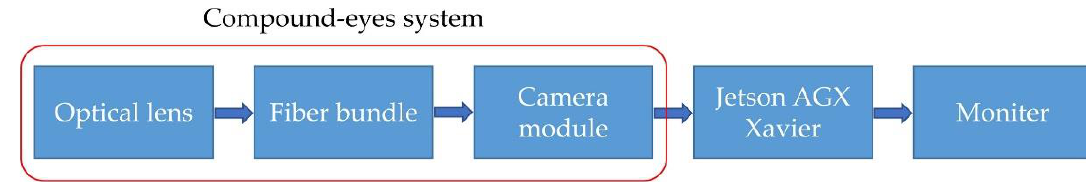
Figure 6. Diagram of the entire system.